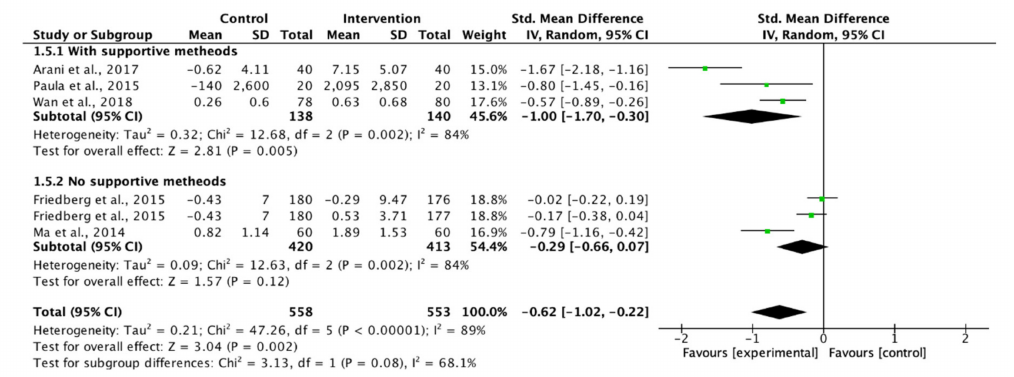
Figure 7. Forest plot of supportive methods on adherence to physical activity recommendations.